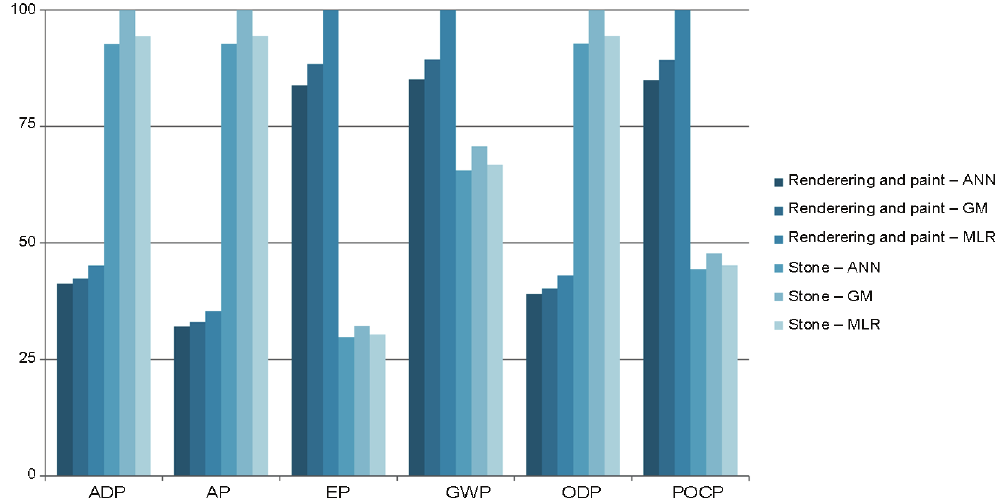
Fig. 2. lCA results (in relative percentage in each environmental category) of each alternative for cumulative stages “A1–A3, B4, C3–C4, and D” using the reference value of stochastic